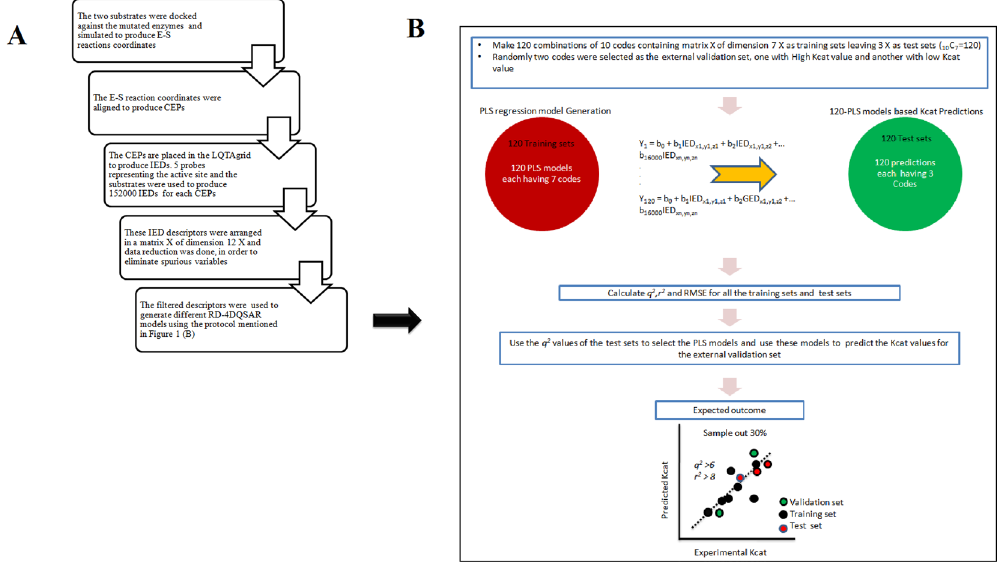
Figure 1. Flowchart of the overall RD-4D-QSAR process. ( A ) The chart explains the steps involved in the generation of interaction energy descriptors of the RD-4D-QSAR paradigm. ( B ) Schematic representation of the protocol that was used to generate different PLS models to derive models with maximum accuracy. Codes represent enzyme variants with different experimental K cat values against two different